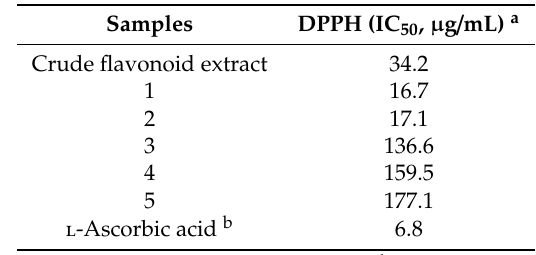
Table 3. Antioxidant activities of compounds 1 – 5